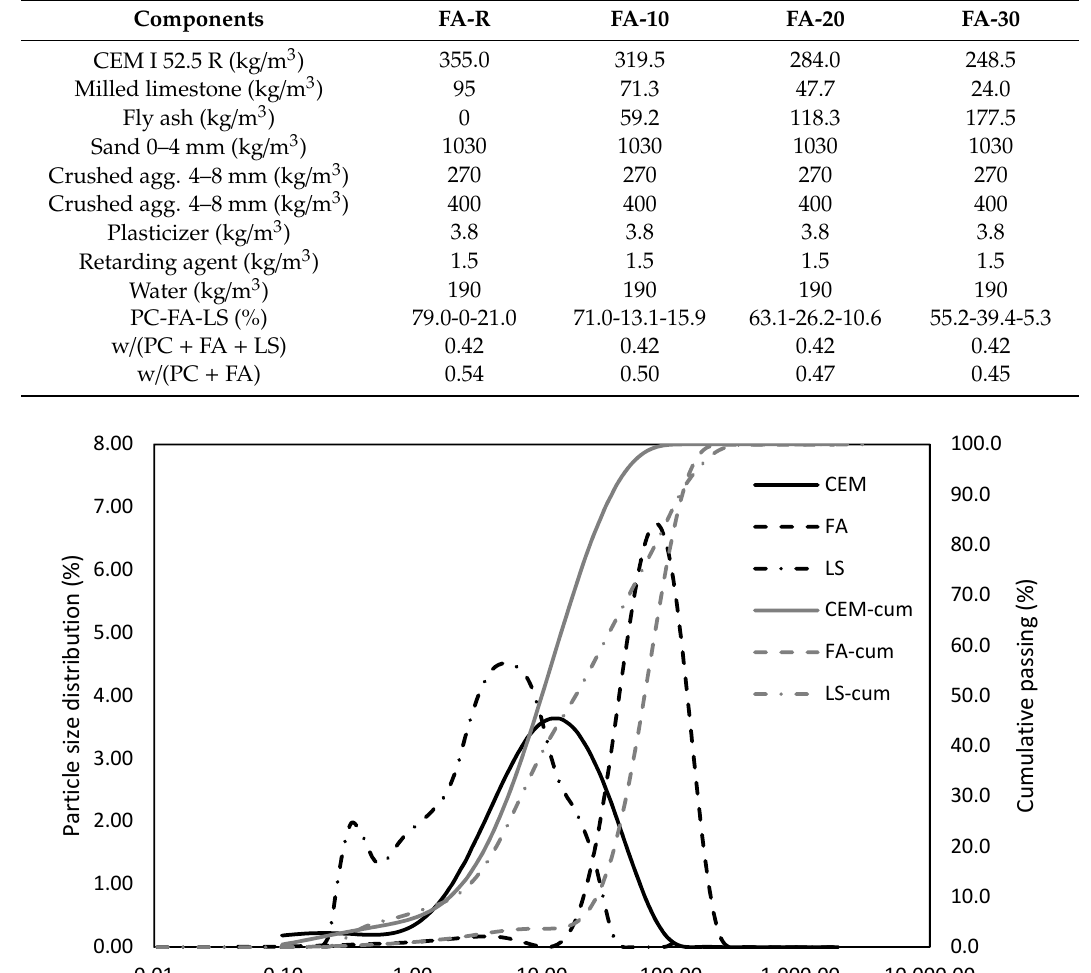
Table 3. Composition of studied SCC mixtures (kg / m 3 ).